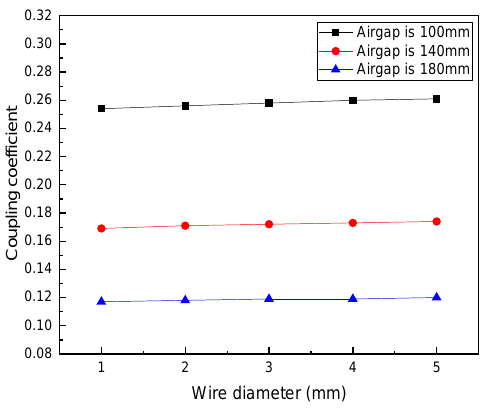
Figure 11. Coupling coefficient versus wire diameter.